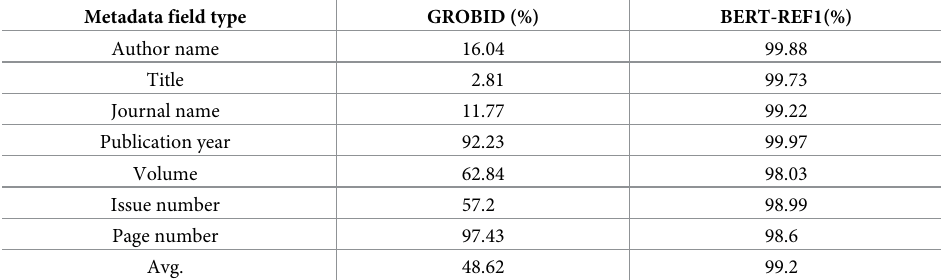
Table 12. Accuracy of the metadata field values extracted from 3,348 non-English references using BERT-REF1 and